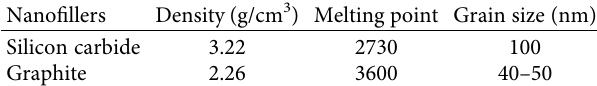
Table 1: Specifications of nano-fillers used in the base